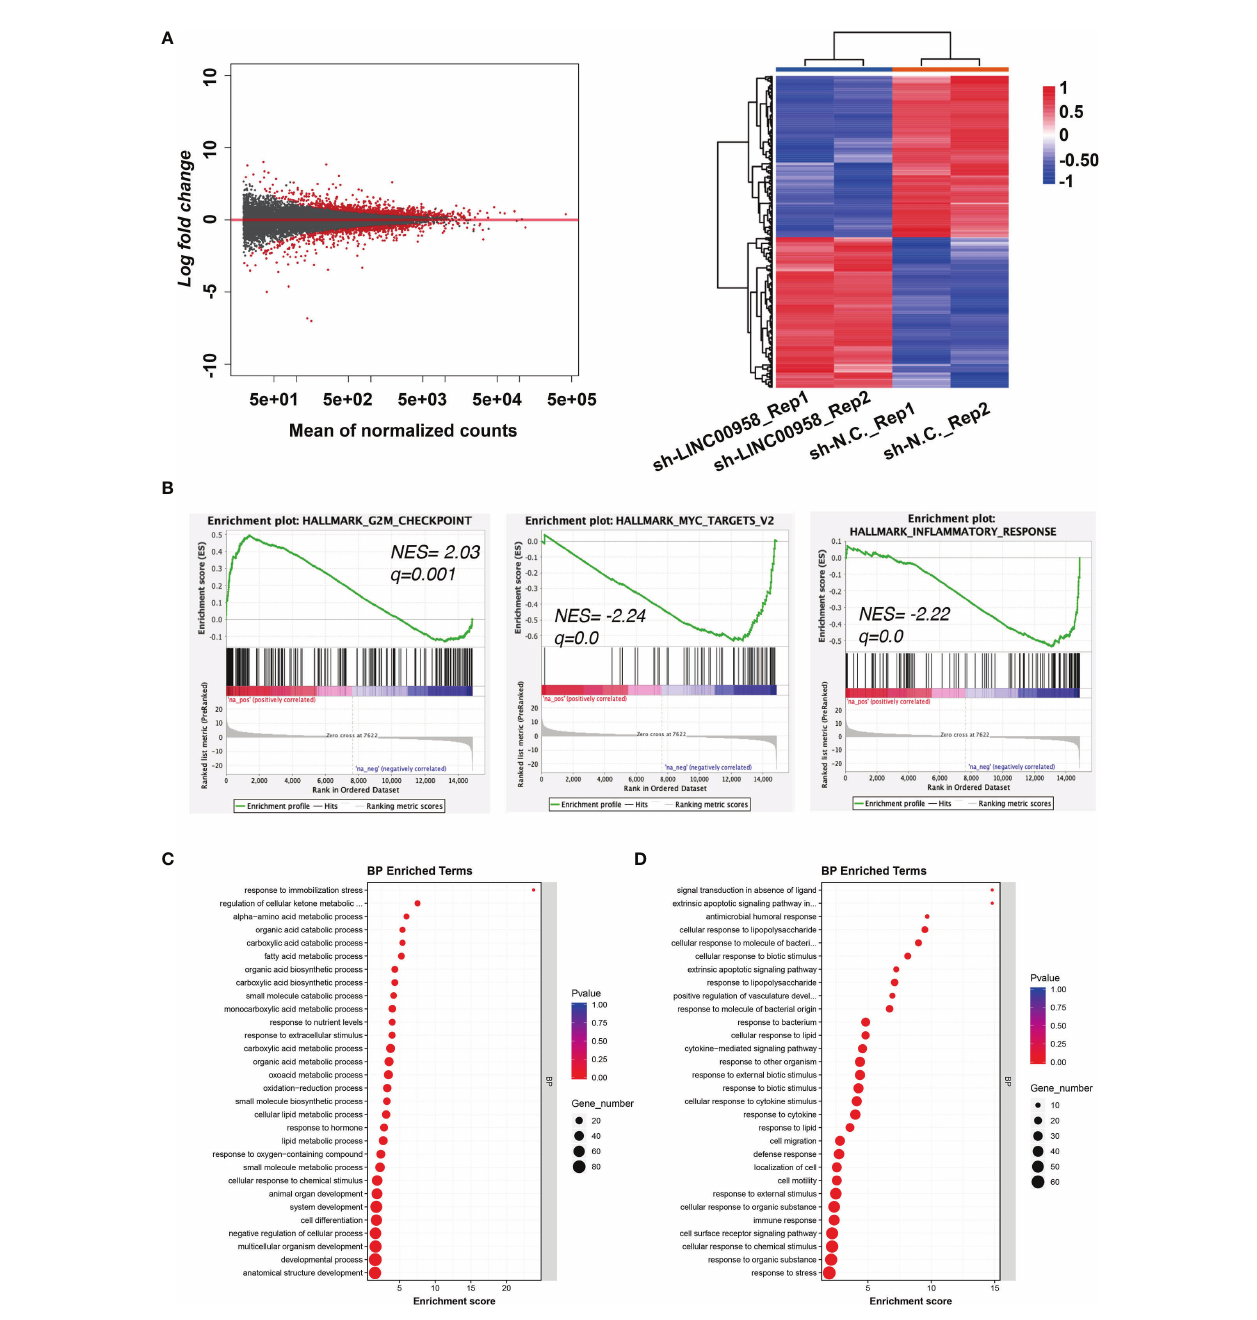
FIGURE 4 | LINC00958 regulated metabolism-related and immune response-related genes. (A) Differentially expressed genes in LINC00958 knockdown cells are shown using a volcano plot and heatmap. (B) Gene set enrichment analysis of the hallmark gene set in the transcriptome of LINC00958 knockdown and control A549 cells. The enrichment of G2M checkpoint, MYC targets, and in fl ammatory response was plotted. (C, D) Gene Ontology analysis of LINC00958-induced upregulated (C) or downregulated (D)